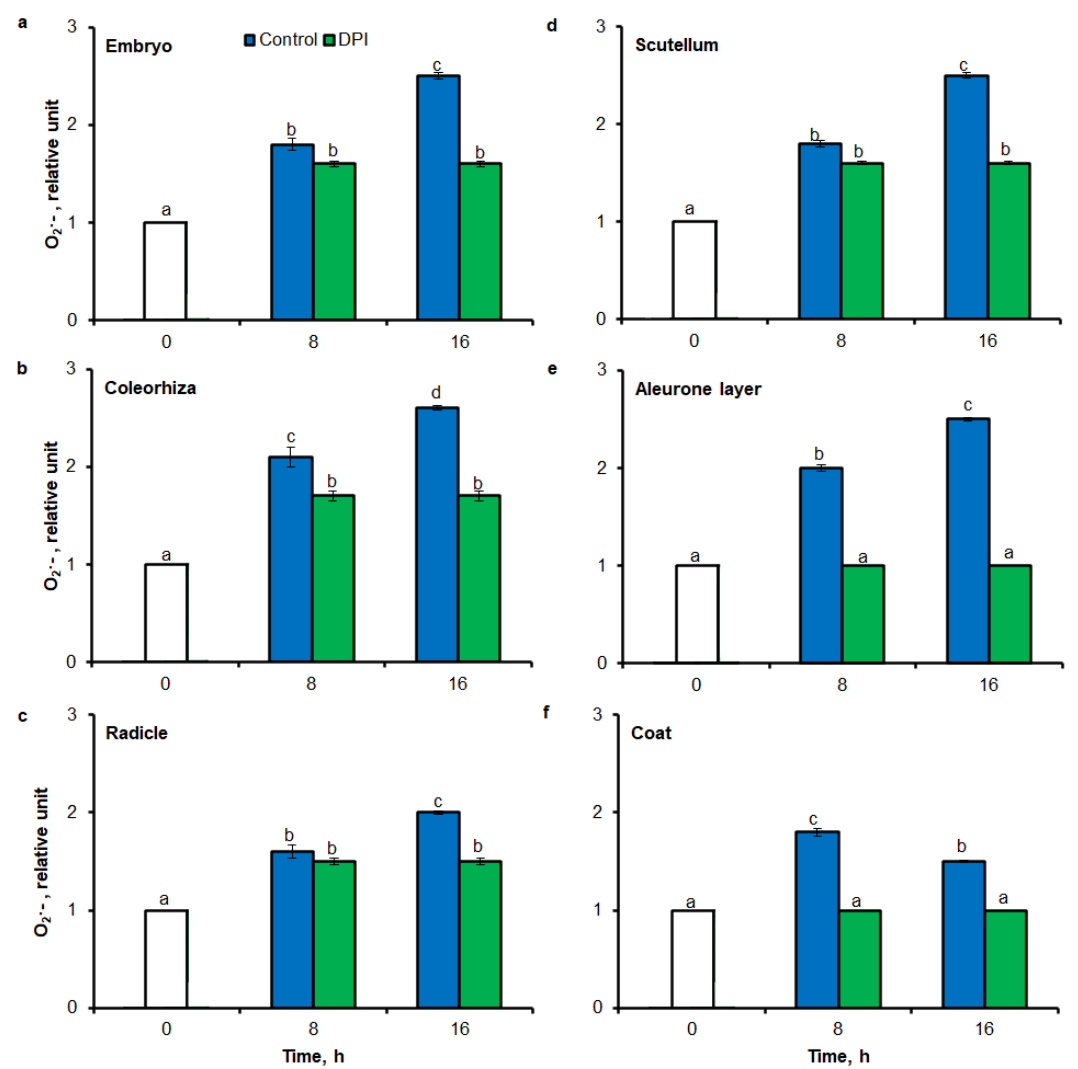
Figure 8. Quantification of O 2 •− in A. fatua embryo ( a ), coleorhiza ( b ), radicle ( c ), scutellum ( d ), aleurone layer ( e ) and coat ( f ) of seeds incubated in water or DPI (10 − 4 M) at 20 °C for different time by spectrophotometric method. Vertical bars indicate ± SD. One ‐ way ANOVA with the Duncan’s post hoc test was used to determine the significance of differences. Mean values with different letters (a–d) are significantly different ( p < 0.05, n = 5).